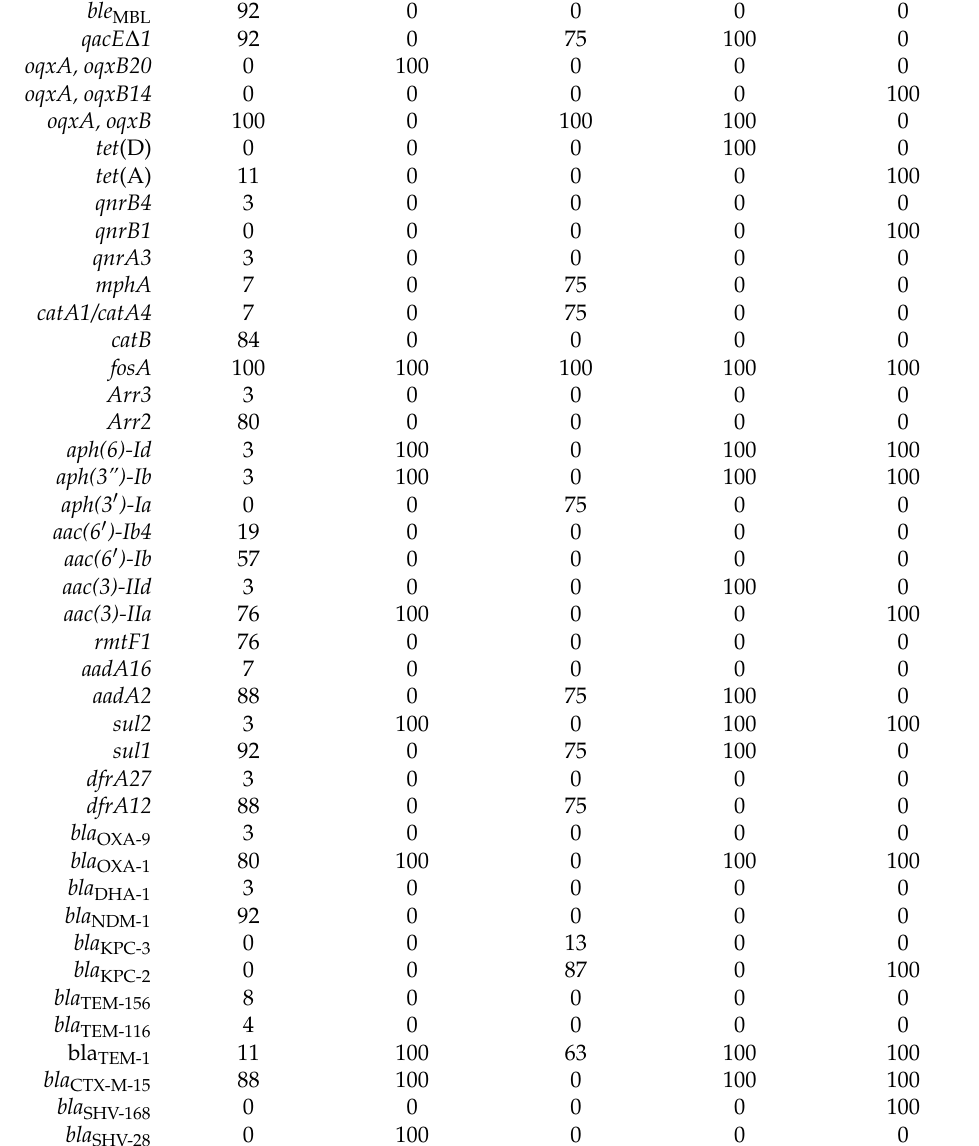
Table 3. Presence of antimicrobial resistance genes (%) in 41 CR K. pneumoniae strains according to sequence